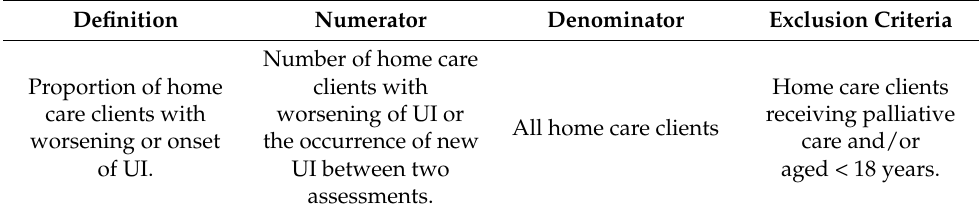
Table 1. Quality indicator bladder incontinence